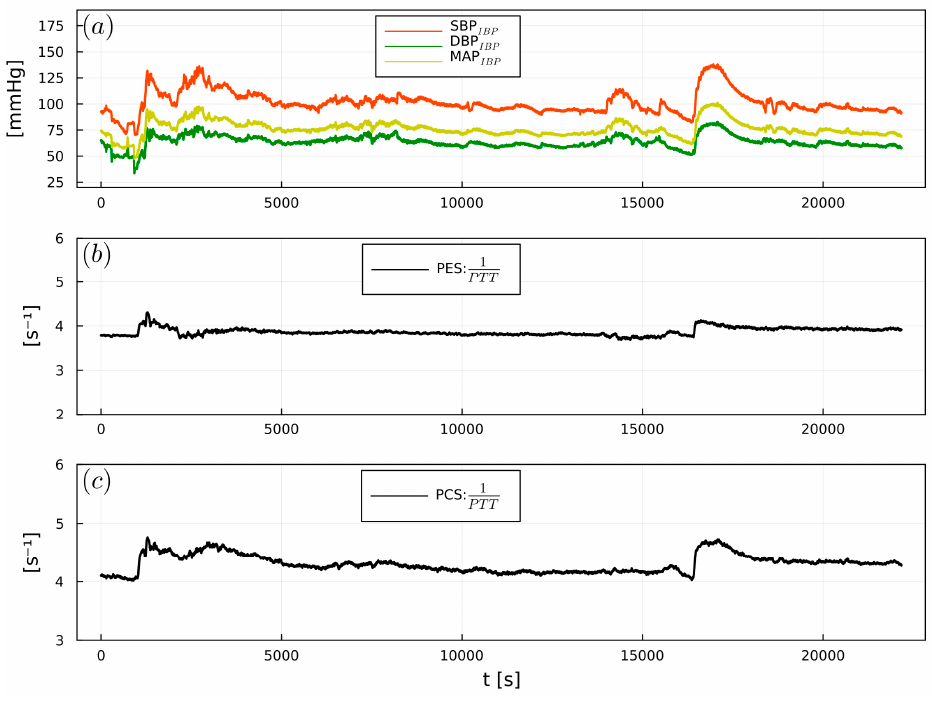
Figure 9. Example of ( a ) intraoperative SBP IBP (red), DBP IBP (green), and MAP IBP (yellow), ( b ) 1/PTT PES , ( c ) 1/PTT PCS , from a urological surgery patient.